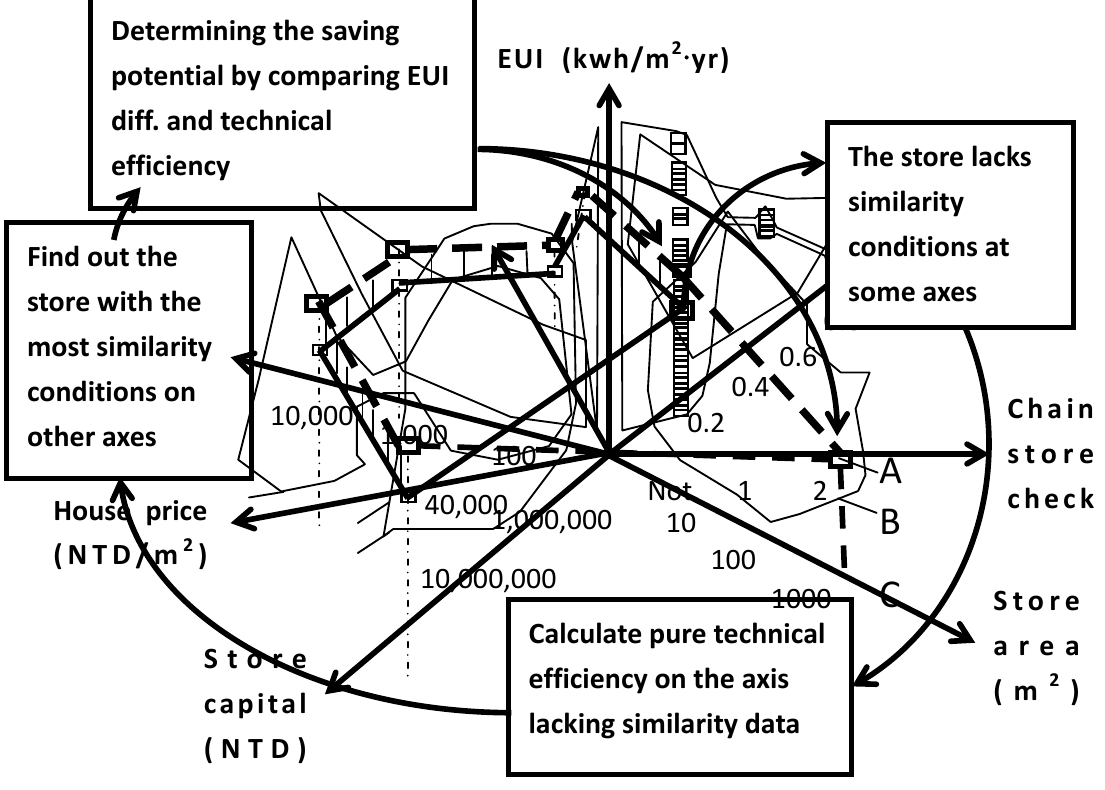
Figure 8. Combined condition analysis as the fourth algorithm data array analyzer: some stores may lack of similarity conditions at some axes of data array. Technical efficiency and similarity conditions are combined to determine energy saving